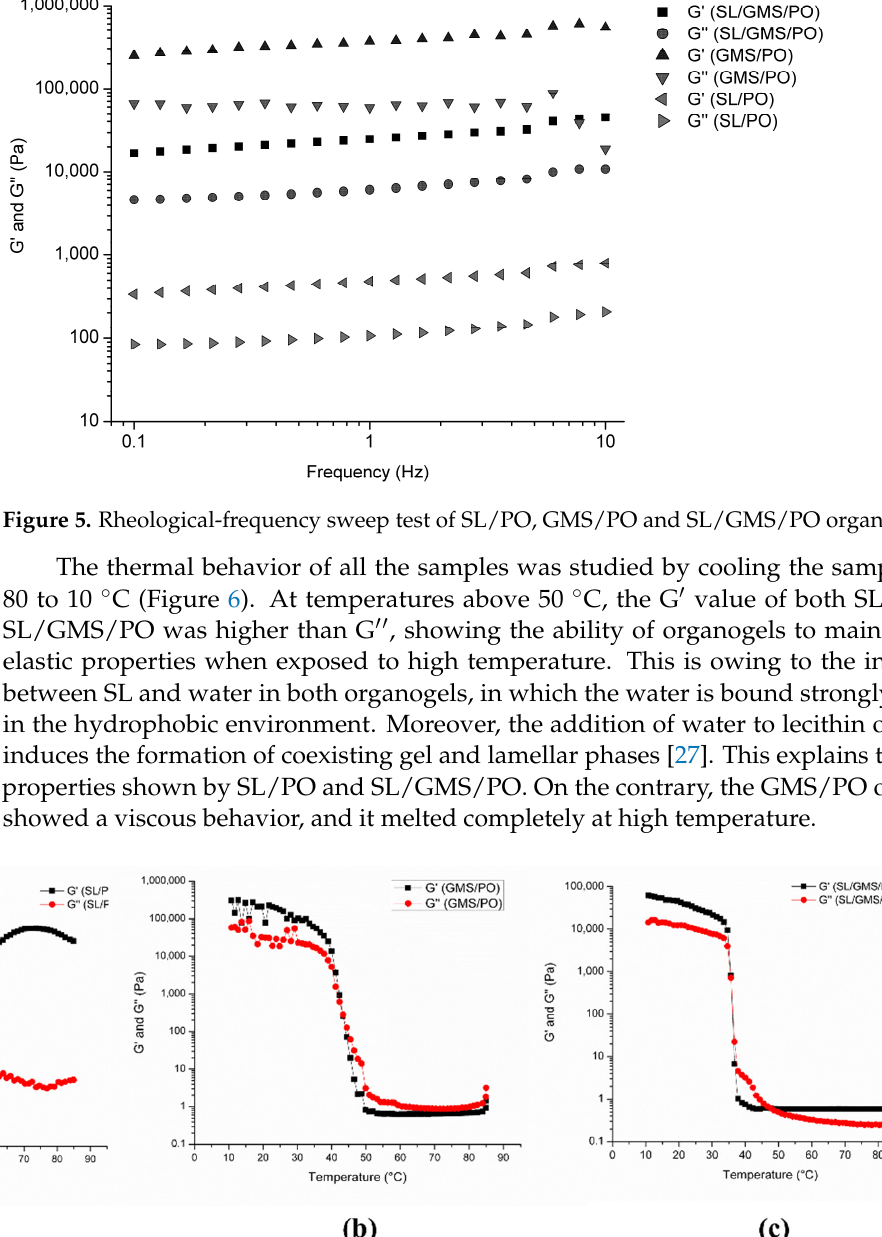
Figure 6. Rheological-temperature ramp test of ( a ) SL/PO, ( b ) GMS/PO, and ( c ) SL/GMS/PO organogels. At temperatures from 45 to 55 °C, a sudden increase in the complex modulus curve was observed in GMS/PO and SL/GMS/PO organogels, indicating the beginning of organogel crystallization. During this cooling process, the gel network structure began to form due to the increased interaction between the organogelator molecules and the aggregation of the molecules over the entire sample. The temperature at which a crossover is observed between G ′ and G ″ is known as the gelation point (Tg), where the system begins to transform from a free-flowing liquid phase to a gelled phase [32]. The measured Tg values of GMS/PO and SL/GMS/PO were 43 and 38 °C, respectively. This observation suggests that the presence of SL molecules in SL/GMS/PO may interfere with the self- assembly of GMS during organogelation, which causes the onset of crystallization in SL/GMS/PO later. At temperatures below 30 °C, G ′ increases slightly due to the reduction